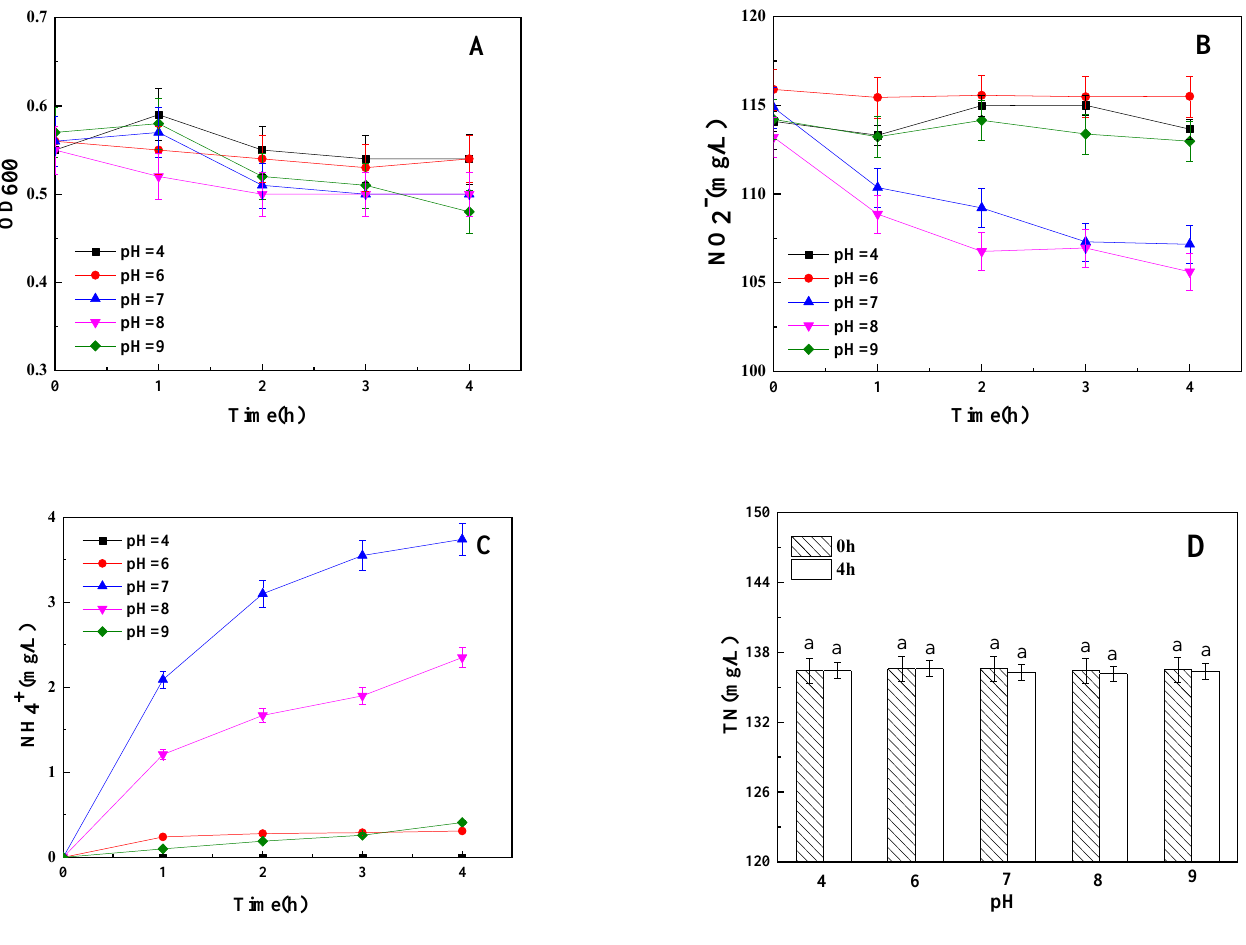
Figure 4. Influence of pH on OD 600 ( A ), NO 2 − ( B ), NH 4+ ( C ), and TN ( D ) by strain Y-9. Values are means ± SD for triplicates. Different letters indicate significant differences between treatments at p < 0.05.